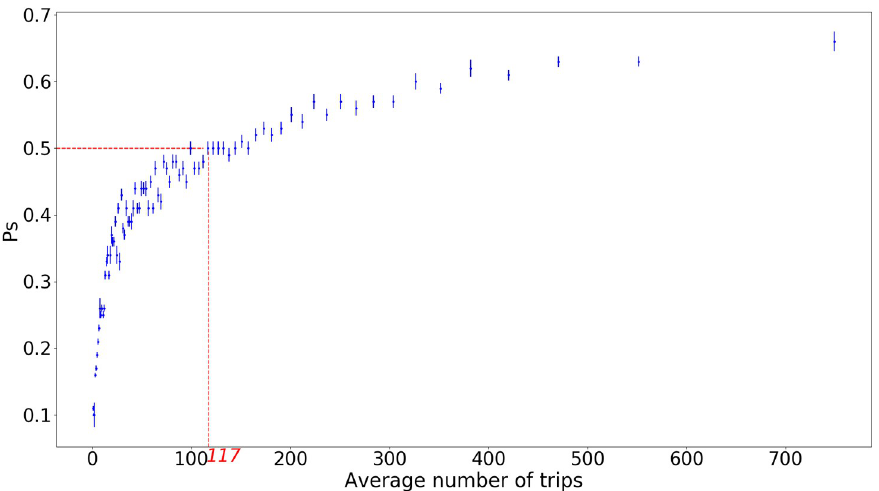
Fig 3. Probability to stay in the system at the end of an adapted year ( P trips during that year. When activity reaches 110-120 trips per year, users are more likely to stay ( P s � 0.5). P s is computed by ranking person-years by increasing activity and averaging over 2500